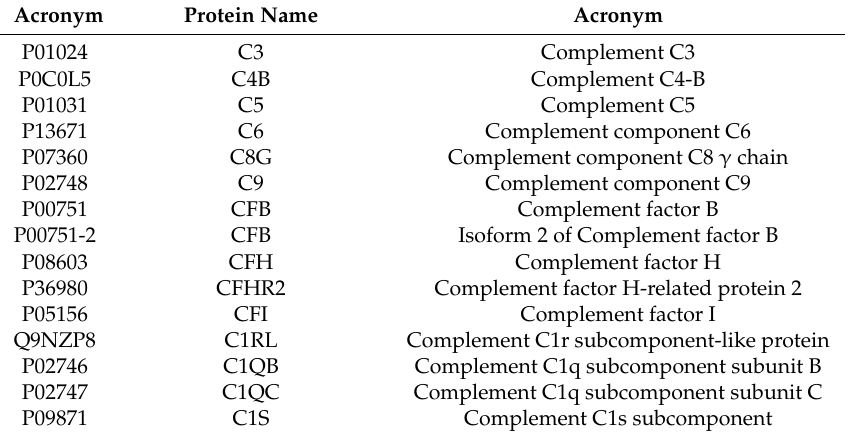
Table A2. Complement components in wound